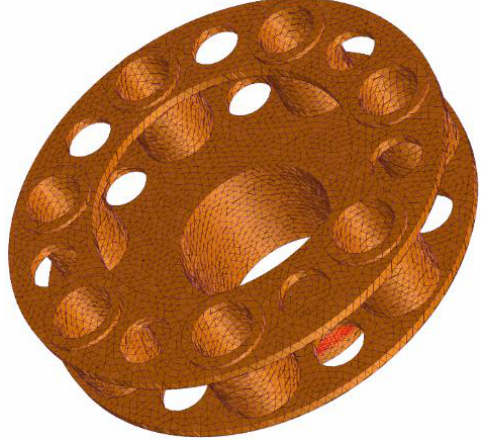
Figure 2. Example of FE model and geometry of planet carrier.